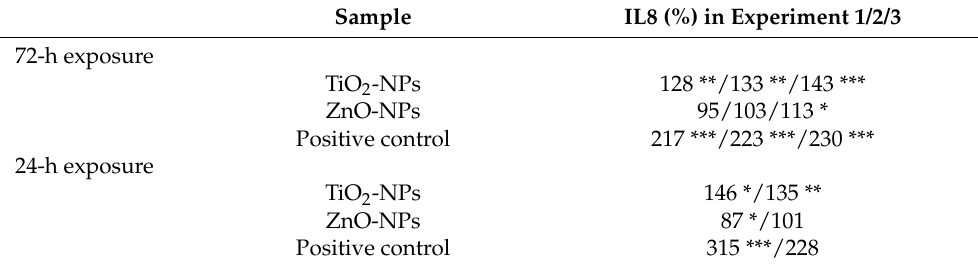
Table 9. Effect of NPs on the secretion of IL8 by T98G cells. T98G cells were exposed to 20 µ g/mL of TiO 2 -NPs or to 5 µ g/mL of ZnO-NP for 24 h or 72 h. Afterwards, IL8 determinations were made following ELISA procedures, as described in Section 4.13. Each experimental condition in each independent experiment was performed with three different wells. The IL contents in the control (unexposed) wells were considered 100%. The treatment done with 300 µ g/mL of lipopolysaccharides from Escherichia coli O55:B5Y was taken as the positive control. The control cultures secreted after the 72-h exposure were 618-, 718- and 644-pg IL8/mL in experiments 1, 2 and 3, respectively. The control cultures secreted after the 24-h exposure were 282- and 370-pg IL8/mL in experiments 1 and 2, respectively. These experiments were run in parallel to the silver NPs and shared controls with the data published by Fuster and coworkers [15]. *** = statistically different from the control for p < 0.00; ** = statistically different from the control for p < 0.01 and * = statistically different from the control for p <